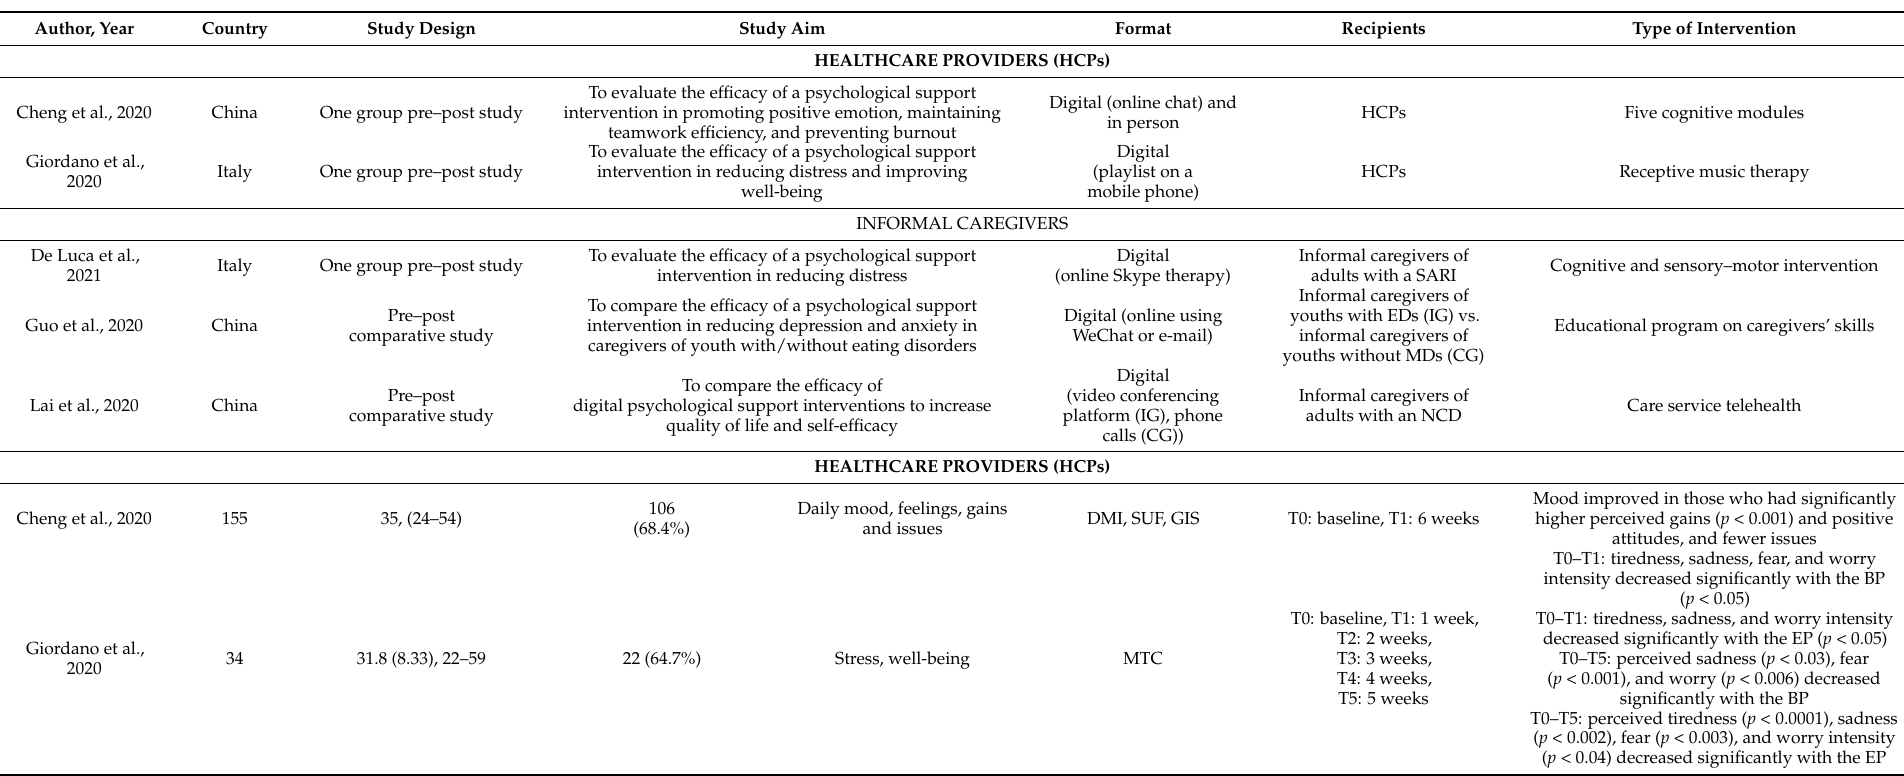
Table 1. Legend (in alphabetical order): BP = Breathing Playlist, CG = Control Group, DMI = Daily Mood Index, ED = eating disorder, EP = Energy Playlist GAD-7 = Generalized Anxiety Disorder-7, GIS = Gain-and-Issue Scale, HCP = healthcare provider, IG = Intervention Group, MD = mental disorder, MTC = Music Team Care, NCD = neurocognitive disorder, PHQ- = Patient Health Questionnaire-9, PSS = Perceived Stress Scale, QoL = quality of life, RCSES = Revised Caregiving Self-Efficacy Scale, SARI = severe acquired brain